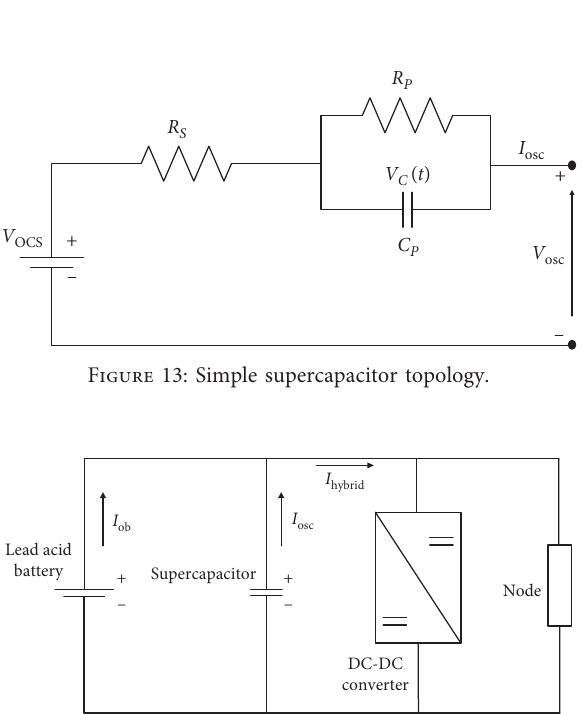
Figure 14: Hybrid of lead-acid battery and